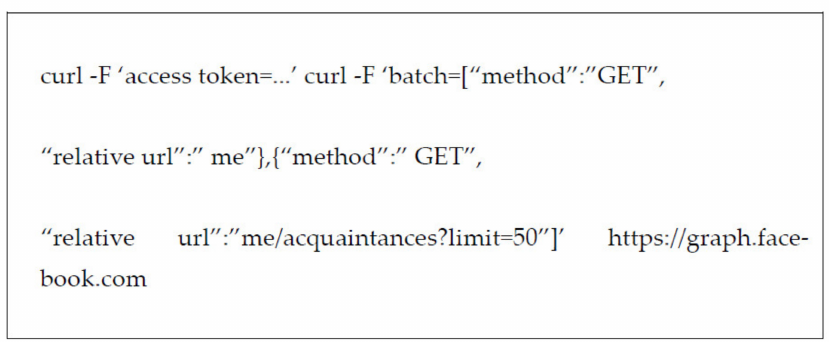
Figure 5. PHP codes for Facebook API data retrieval.